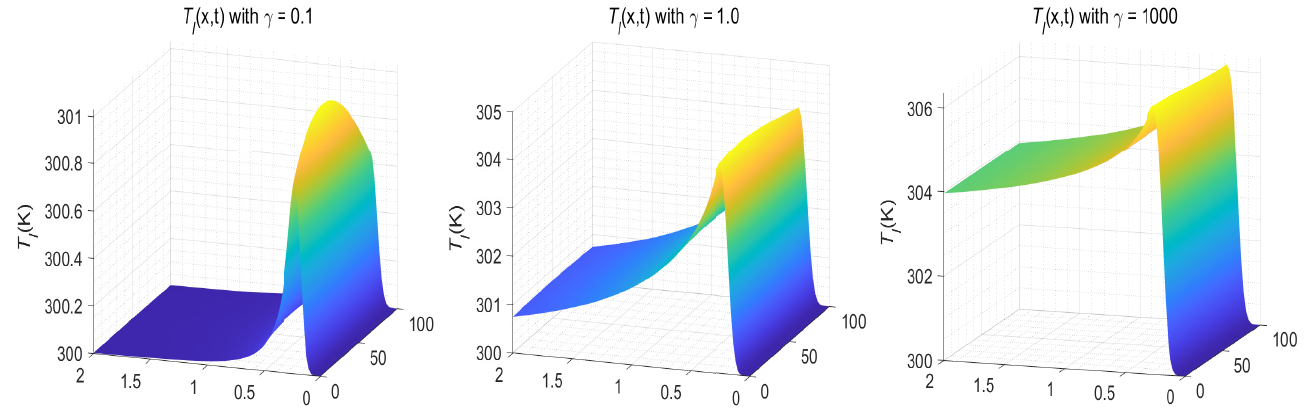
Figure 19. Temperature distributions of T l versus ( x , t ) with various γ when K n = 6.184658, ( α , β ) = ( 0.3,0.8 ) , N = 100, and M = 100 for Example